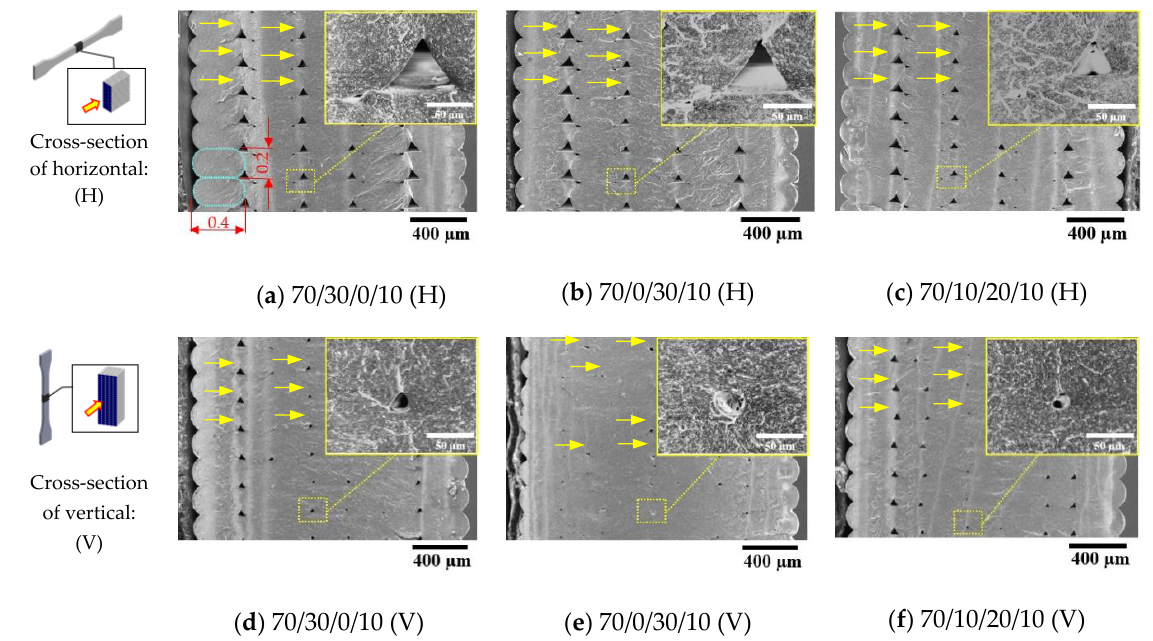
Figure 6. SEM images of the cross-sectional surface of PLA/PBAT/PBS/nano talc composite 3D prints: ( a – c ), SEM images from a horizontal dumbbell; ( d – f ), SEM images from a vertical dumbbell; (examples of void areas were identified by yellow arrows). Table 7. Void area and properties of PLA/PBAT/PBS/nano talc composite 3D